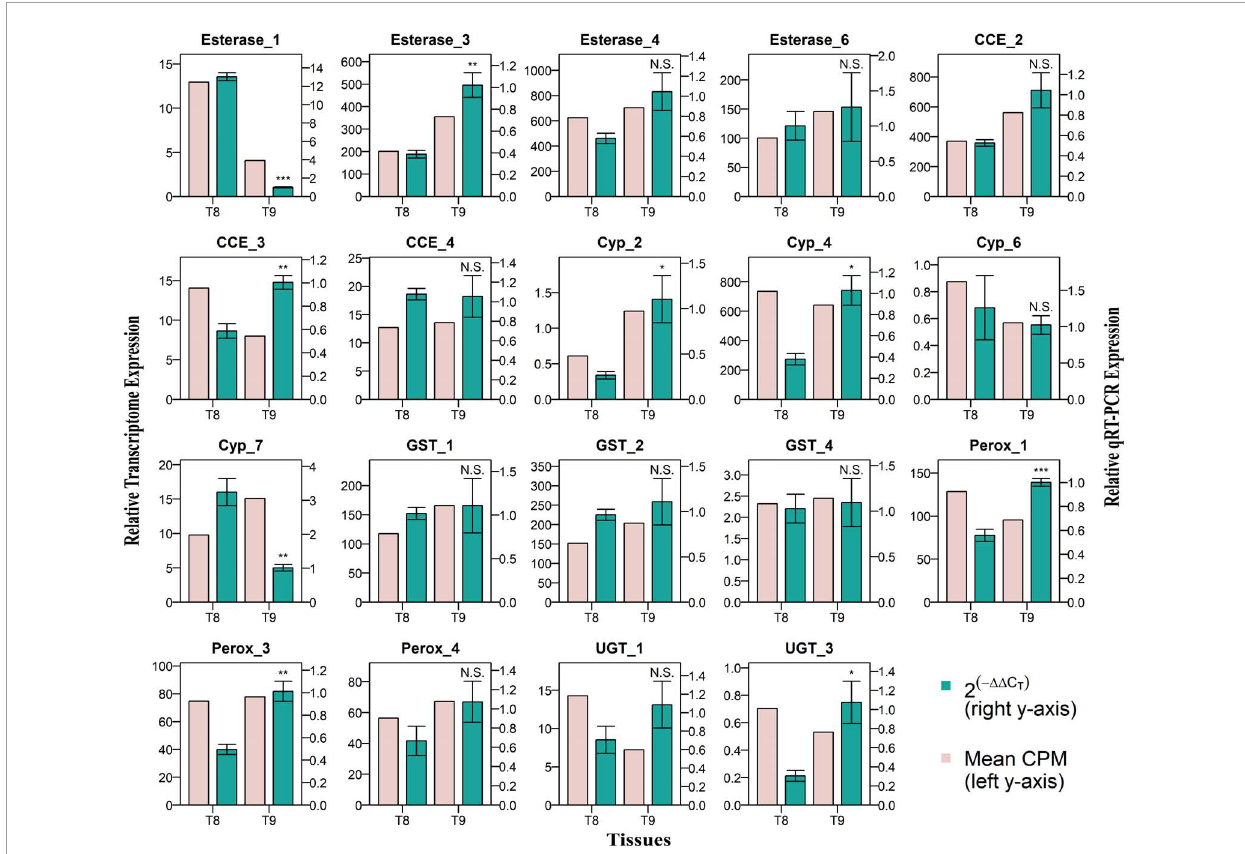
FIGURE13 Comparison of RNA-seq and RT-qPCR data for the relative expression of 19 genes during RT-qPCR in the fat body tissues. Callow female fat body (T8) and callow male fat body (T9) on the x -axis plotted against relative expression in RNA seq ( N = 5) represented as mean CPM on the left y -axis, and relative expression in RT-qPCR ( N = 4) represented as mean 2ˆ-( (cid:49)(cid:49) Ct) ± S.E. on the right y-axis. Light brown bars represent mean transcriptome expression, and dark green bars represent RT-qPCR expression. Student’s T -test was performed with a 95% confidence level, and p -values were generated after comparing RT-qPCR expression between T9 vs. T8. * represents p < 0.05, ** represents p < 0.01, *** represents p < 0.001, and N .S. represents the non-significant